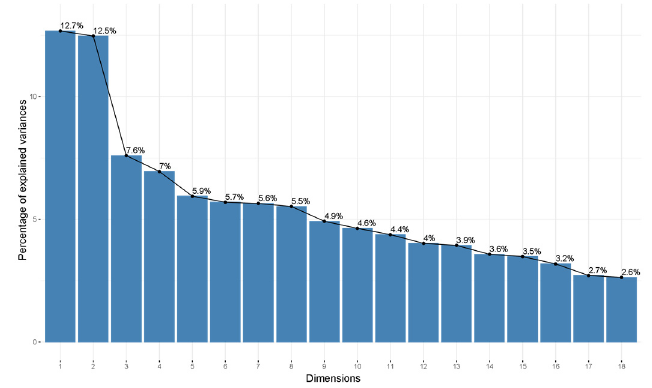
Figure A1. MCA. Decomposition of total inertia.